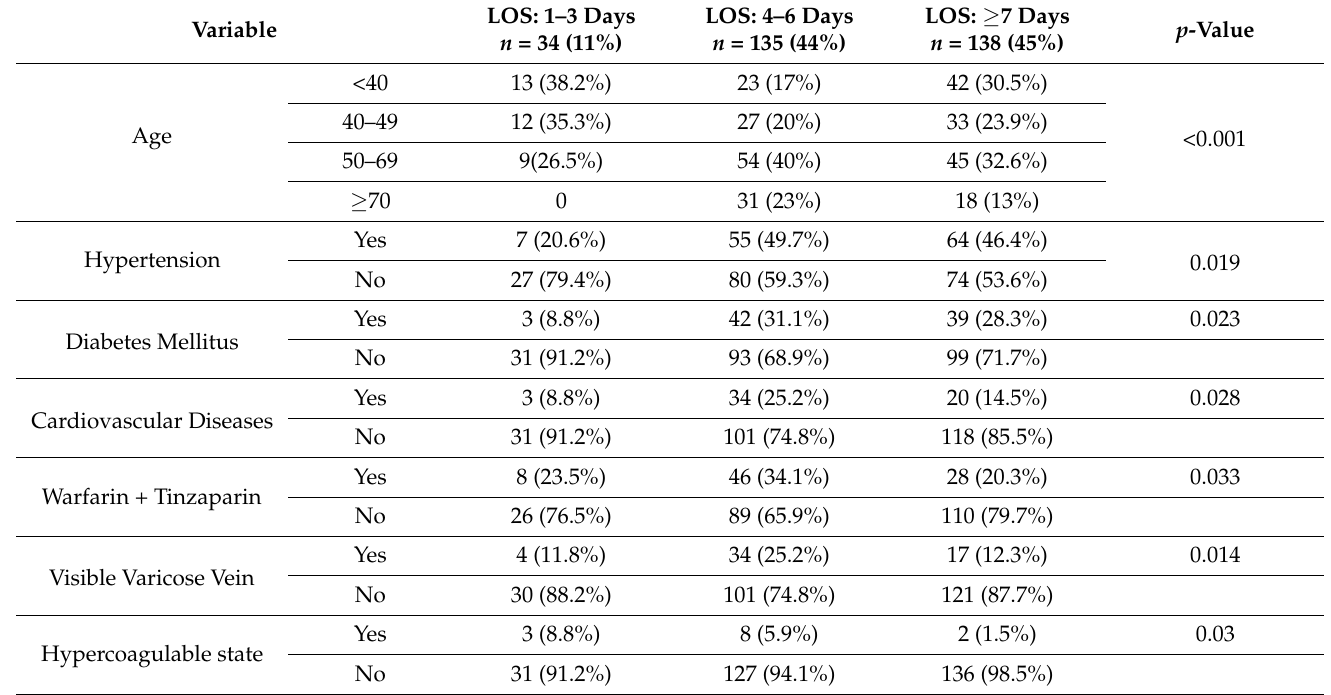
Table 3. Significant predictors of Hospital Length of Stay (LOS) among patients with Venous Throm- boembolism: Results from the univariate analysis.